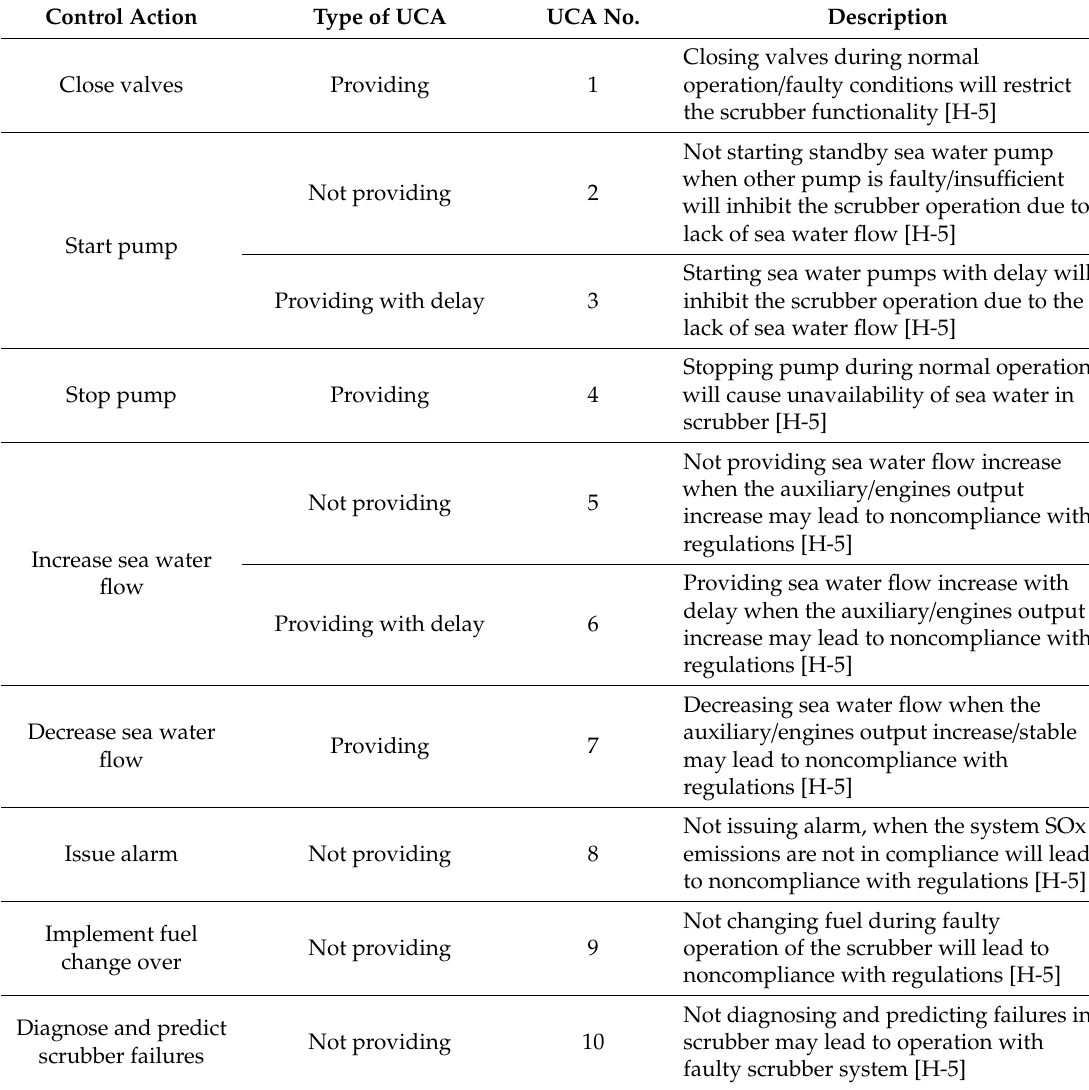
Table 6. Identified